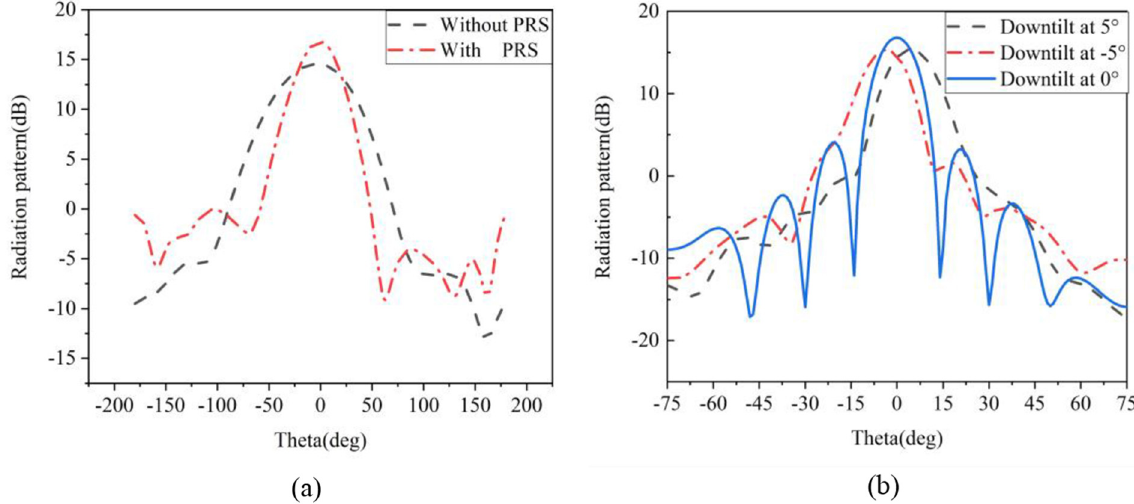
Fig. 7. (a) Simulated gain of the BSAA with or without PRS, (b) simulated down-tilted mainlobe of the BSAA at 0 ° and±5 °